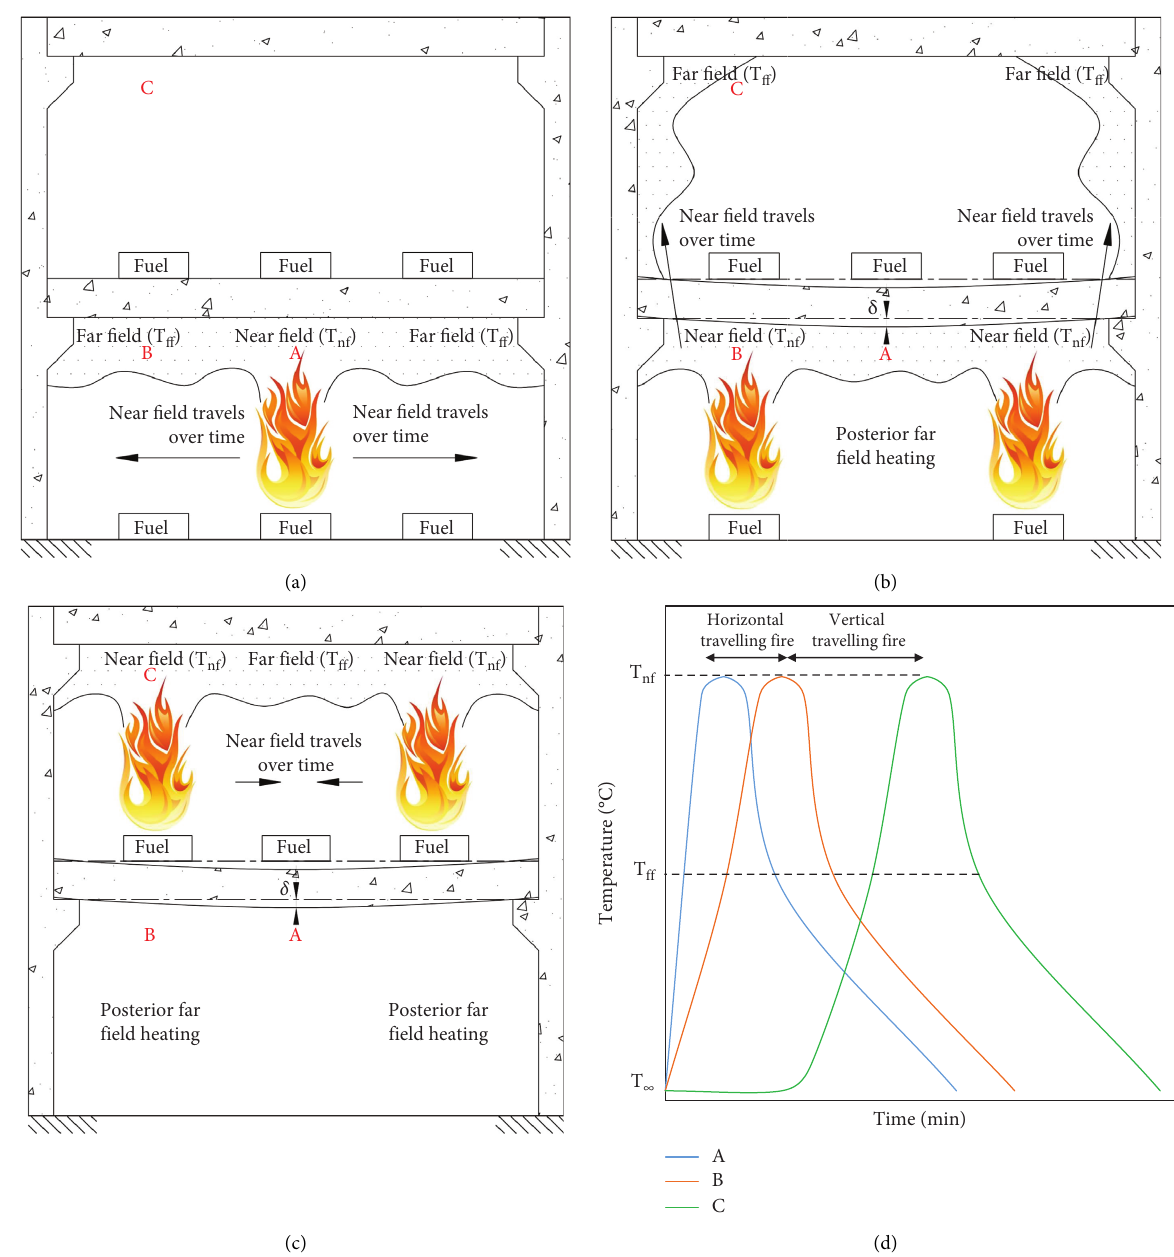
Figure 2: Temperature development due to localised travelling fire: (a) horizontal, (b) vertical, (c) horizontal, and (d) temperature-time curves at A, B, and